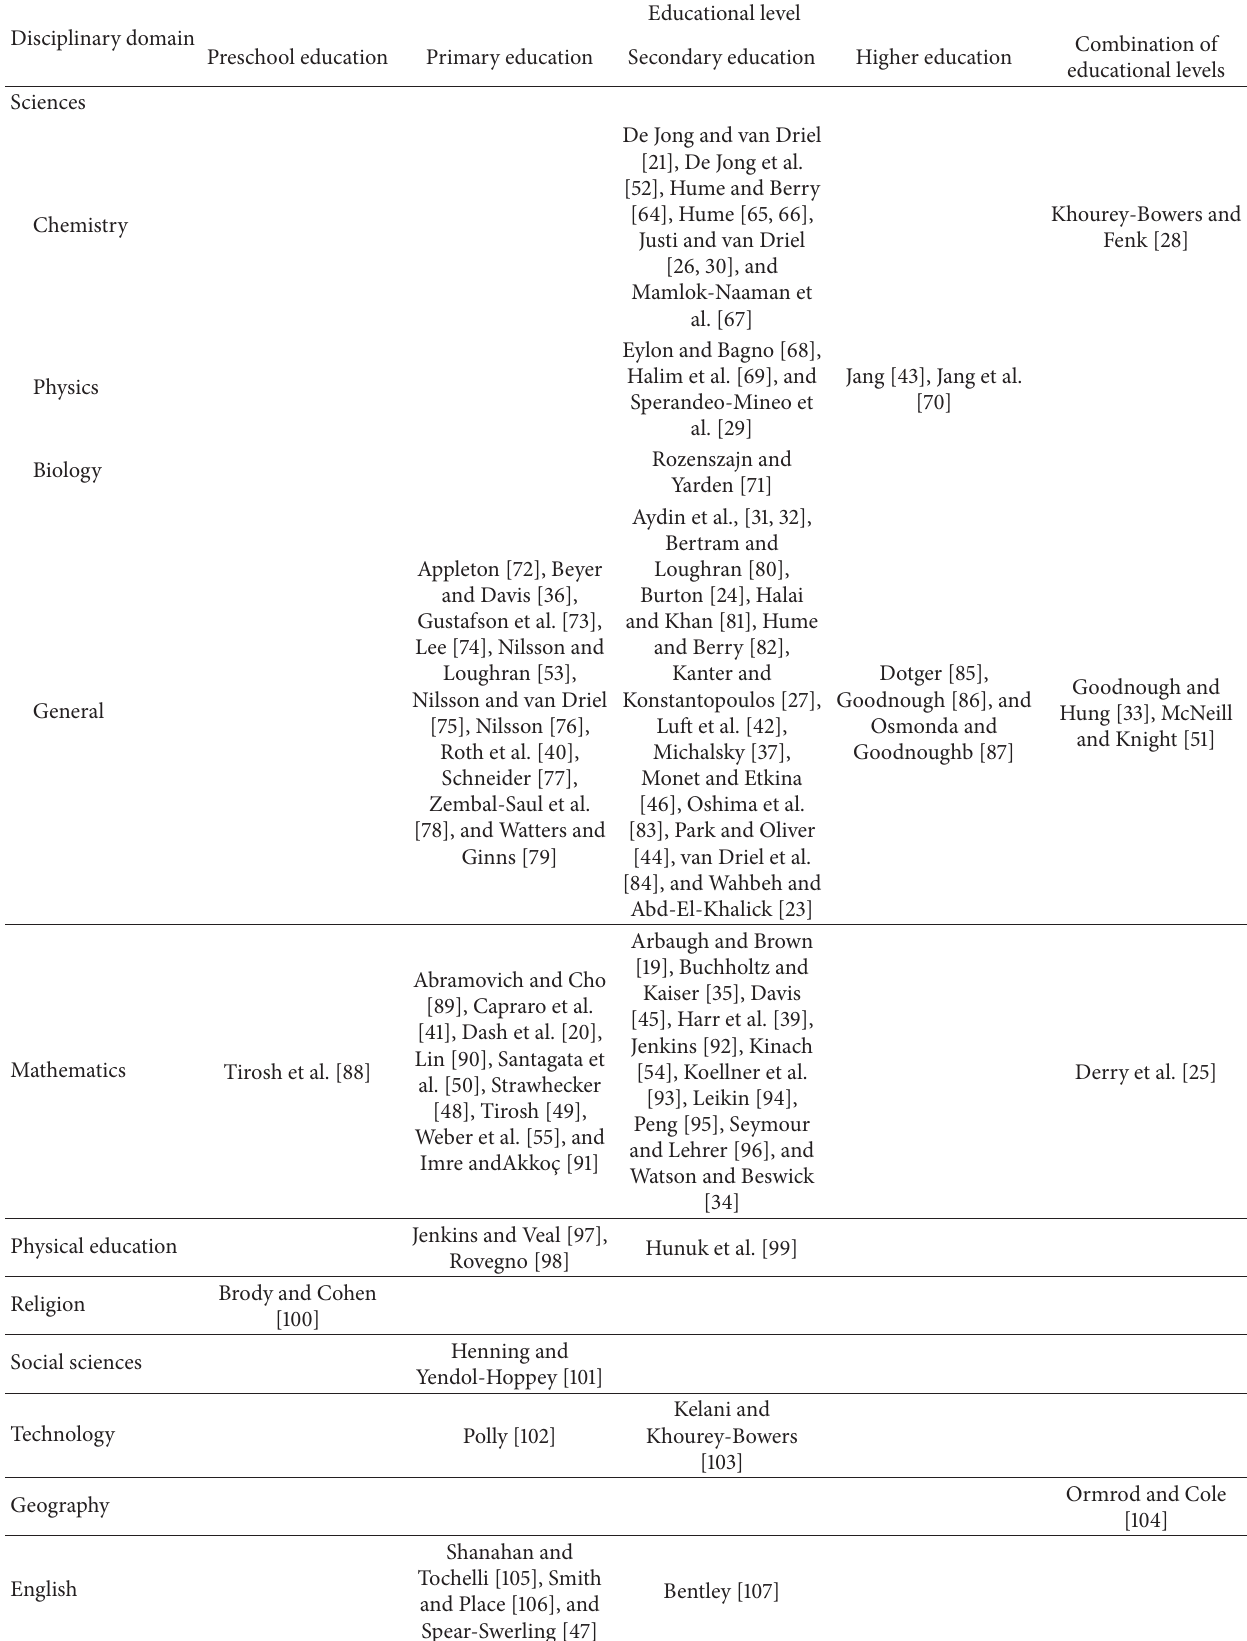
Table 1: Overview of disciplinary domains and educational